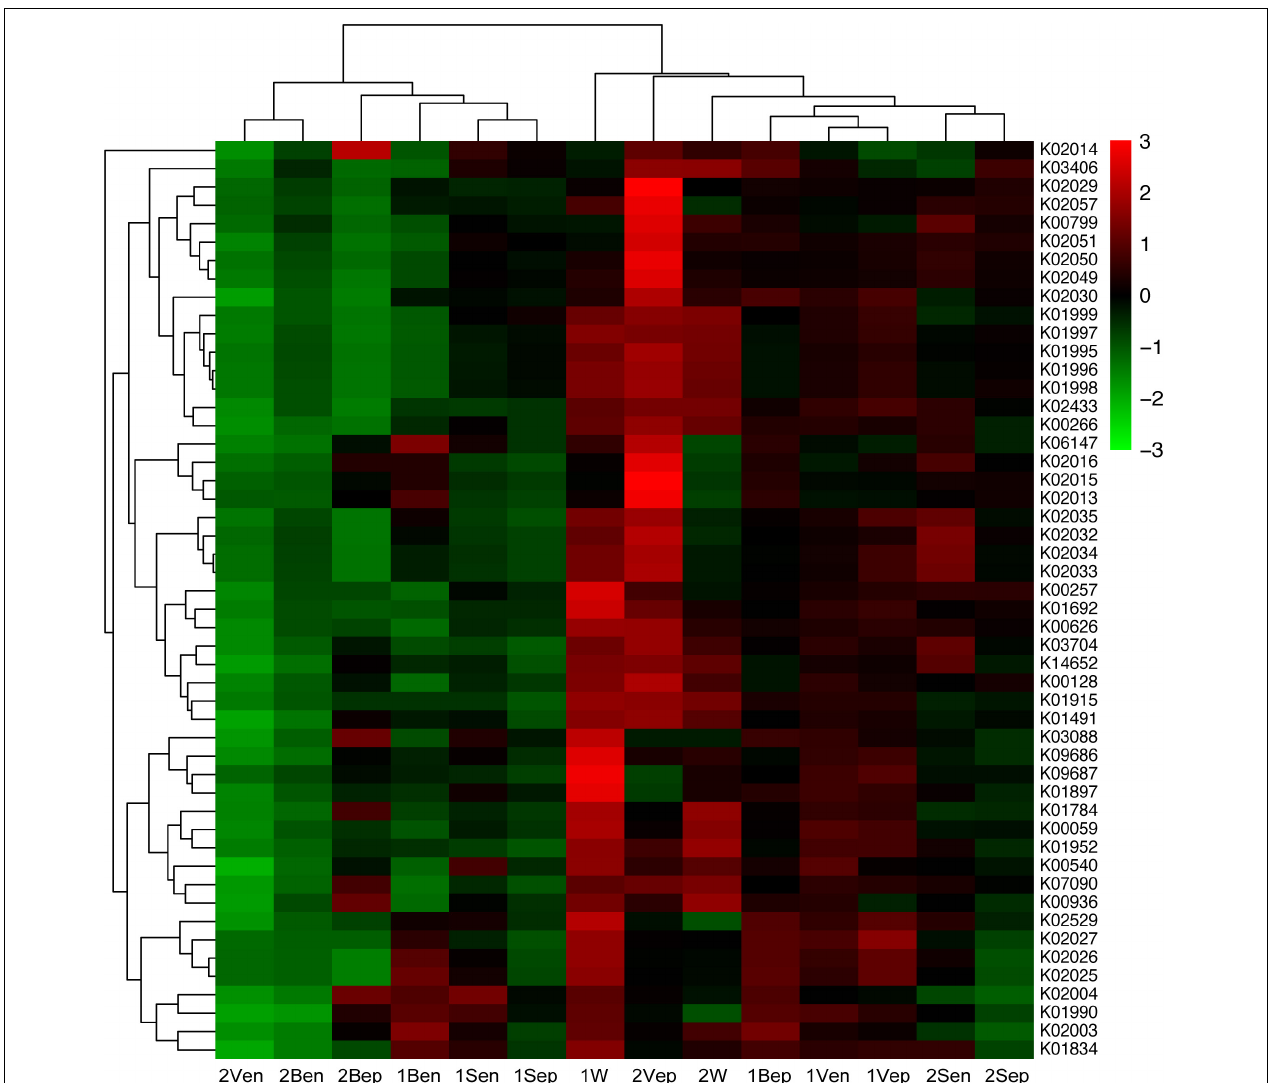
FIGURE 12 | Heat-map of top 50 abundant functional proteins combined with the phylogenetic distribution of samples clustered by Hierarchical cluster. The color key scale represented the abundance of corresponding proteins. Each row represented the abundance distribution of right KEGG orthologous category (KO) among samples, and each column represented the abundance distribution of various KO in each sample whose name was shown at bottom. Lateral topology was contributed by the similarity of KO abundance distribution among different samples, and longitudinal topology was contributed by similarity of different KO species distribution in each